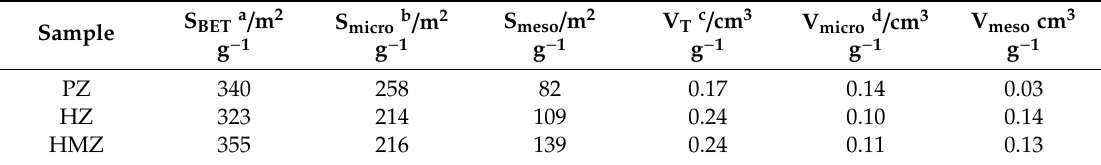
Table 1. Textural properties of three samples.